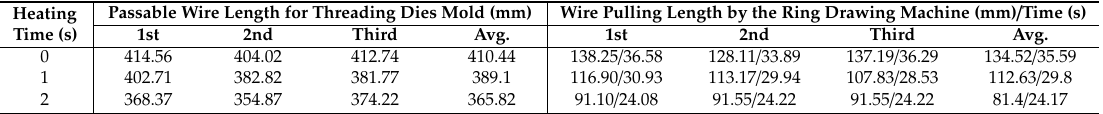
Table 13. Results based on wire pulling speed: k2(3.78 mm /